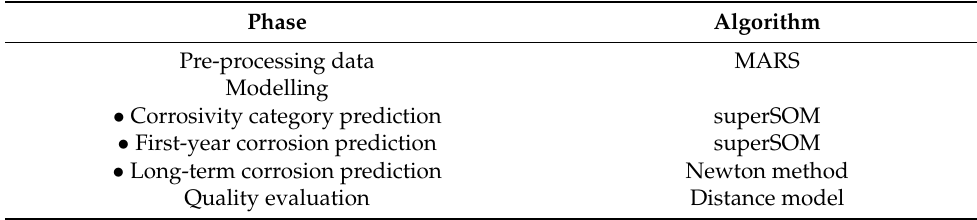
Table 3. Summary of all models used.